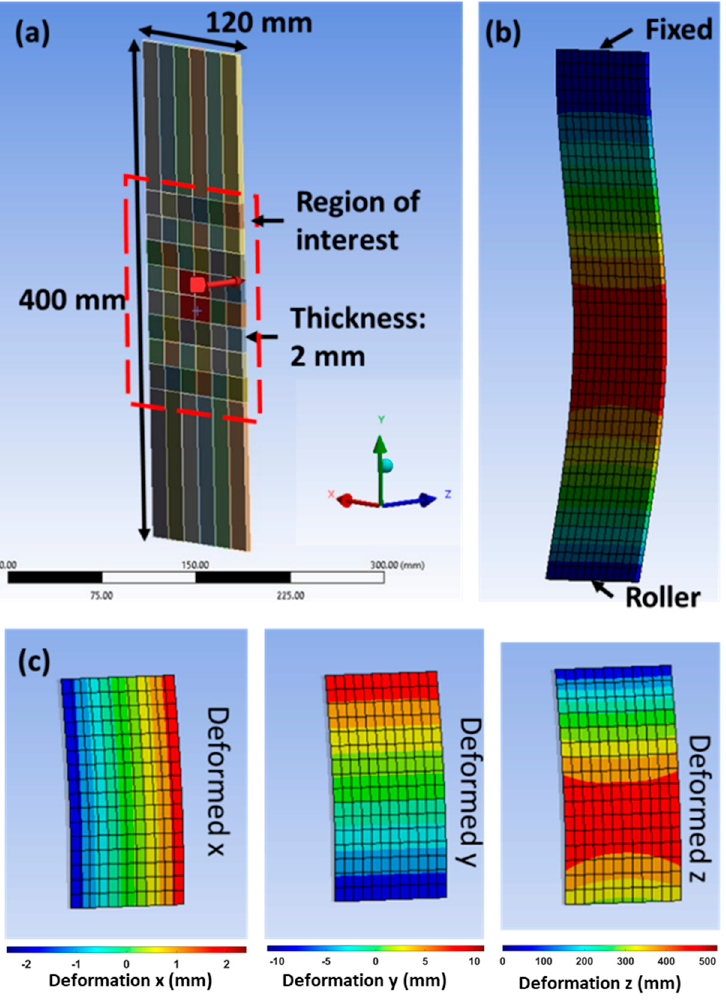
Figure 5. ( a ) A rectangular thin membrane model; ( b ) deformed shape after applied load at the middle of the thin membrane; ( c ) directional deformation of the membrane model.